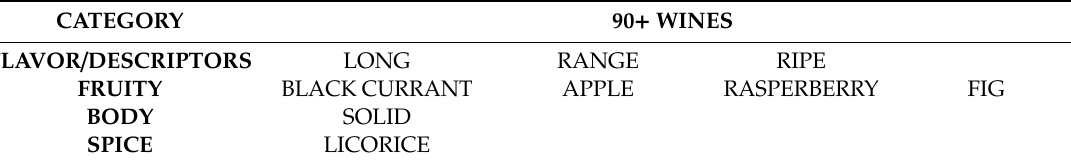
Table 4. Distinct keywords between 90 + and 89 − wines from ALL Bordeaux Wine dataset in 90 + wines. CATEGORY 90 +